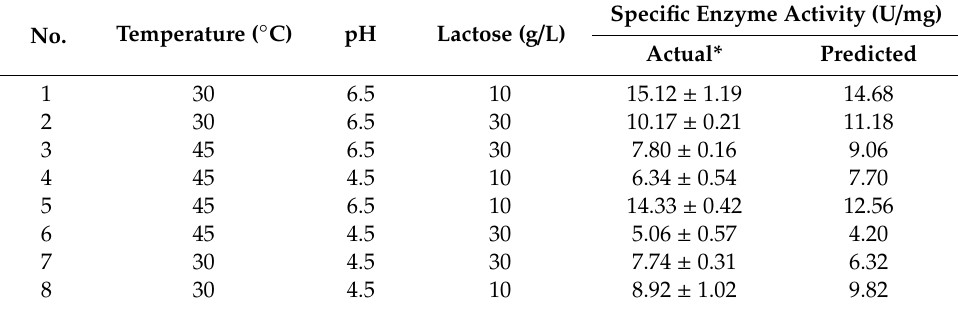
Table 6. The results of Plackett–Burman design for two levels of independent factors.